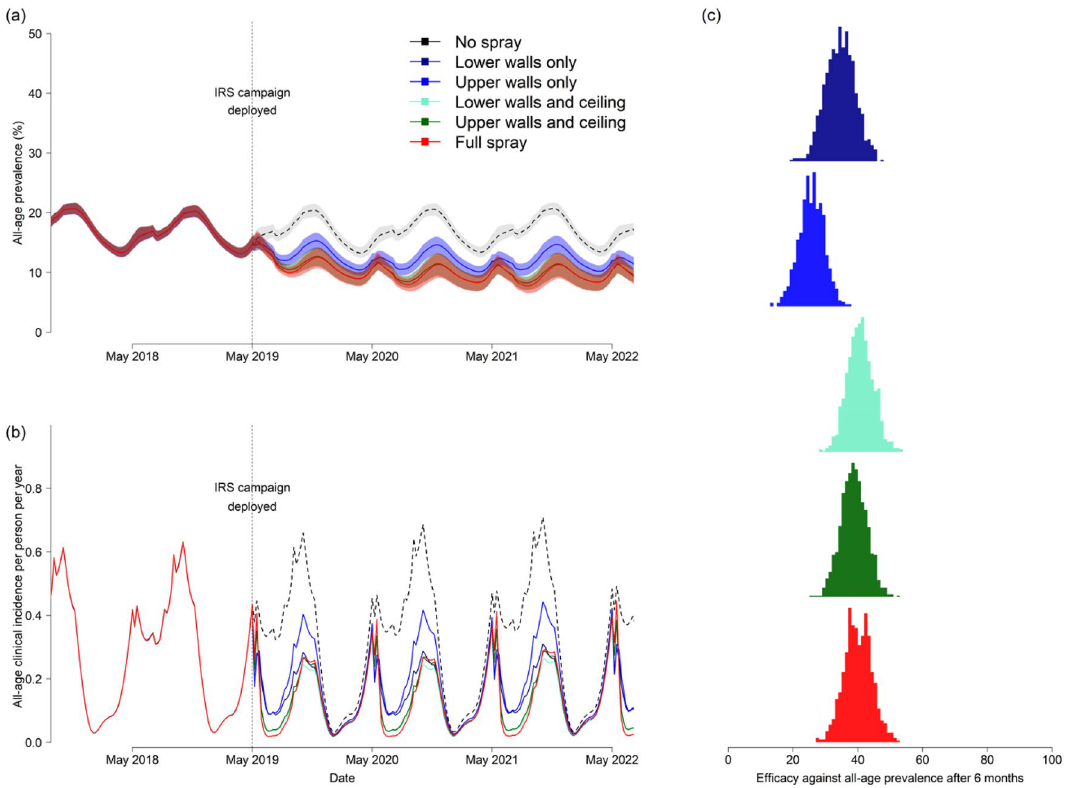
Figure 6. Model predicted epidemiological impact of partial versus full IRS with pirimiphos-methyl CS. In all panels, the different partial IRS scenarios are shown as: lower walls only (dark blue), upper walls only (light blue), lower walls and ceiling (light green), upper walls and ceiling (dark green), or full spray (red). The model uncertainty (95% uncertainty intervals) is shown in panel ( a ) and ( c ) around the mean (line, panel ( a )). Panel ( a ) shows the model simulated all-age malaria prevalence (mean, lines, and 95% uncertainty intervals (shaded polygons)) over time with the spray campaign taking place annually from May 2019 onward. The no spray counterfactual (grey dashed line and shaded polygon) is used to compare with all spray strategies to estimate the efficacy against prevalence (as shown in Table 1 and panel ( c ) at 6 months after the first spray campaign). ( b ) The corresponding model estimates of all-age clinical incidence of malaria (mean estimate over time for clinical cases per person per year) for the same trial arms and counterfactual simulation. The vertical dotted lines on panel ( a ) and ( b ) in May 2019 indicate the time when spray was deployed. ( c ) The model predicted efficacy against all-age malaria prevalence relative to no spray campaign (grey dashed lines on panels ( a )) at six months post-IRS for each spray strategy respectively. The uncertainty is carried through from the model simulations and parameter uncertainty in IRS efficacy estimates (Supplementary File 2) and shown by the width of the histogram for each spray strategy.